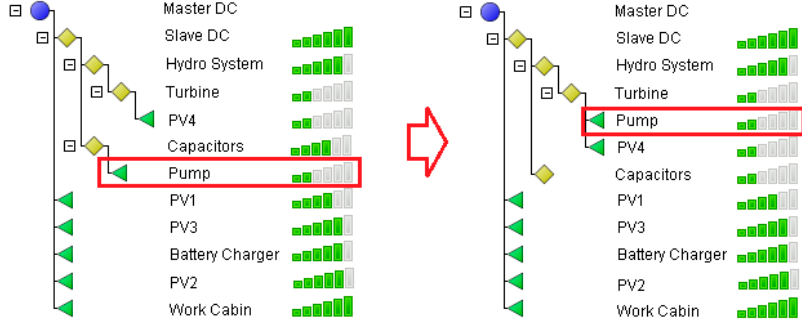
Figure 15. Change of switch for the pump SN when the pump is working and the rest of surrounding devices are connected.